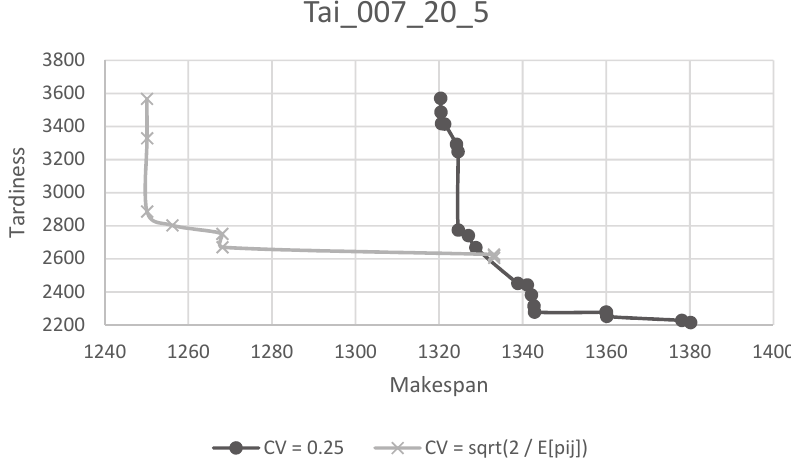
Fig. 4. Pareto fronts of Taillard’s instance 7 (20 jobs × 5